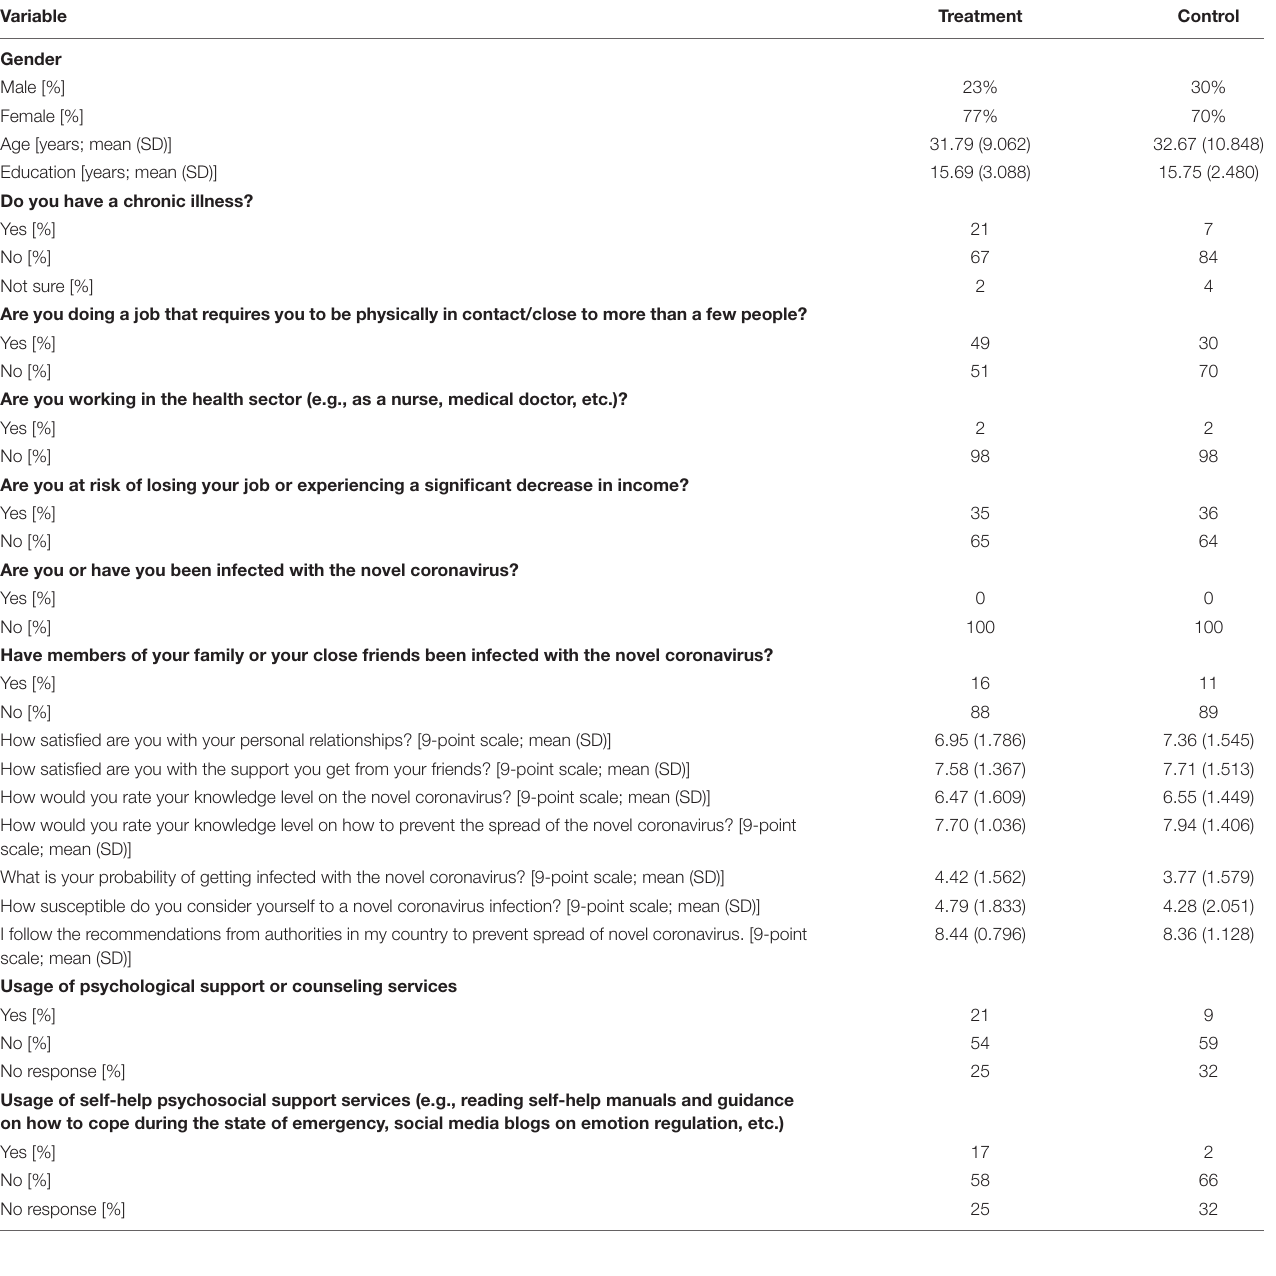
TABLE 1 | Demographic characteristics of the